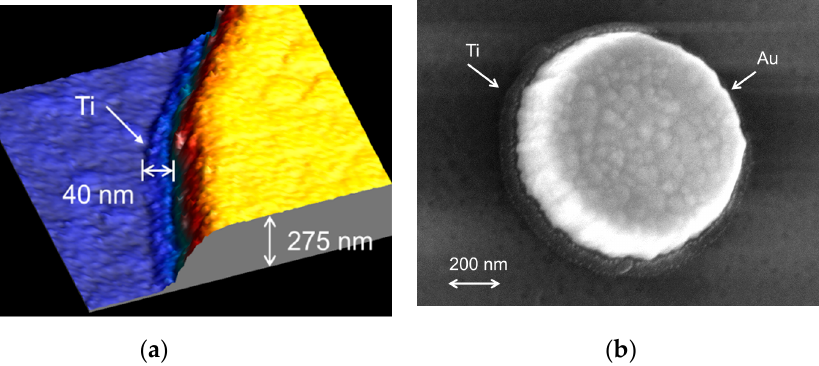
Figure 2. ( a ) AFM image of a gold pad (1 µm diameter and 275 nm height) and an underlying Ti layer with an exceeding 40 nm width on a MC2 sample. ( b ) SEM image of similar gold pad.